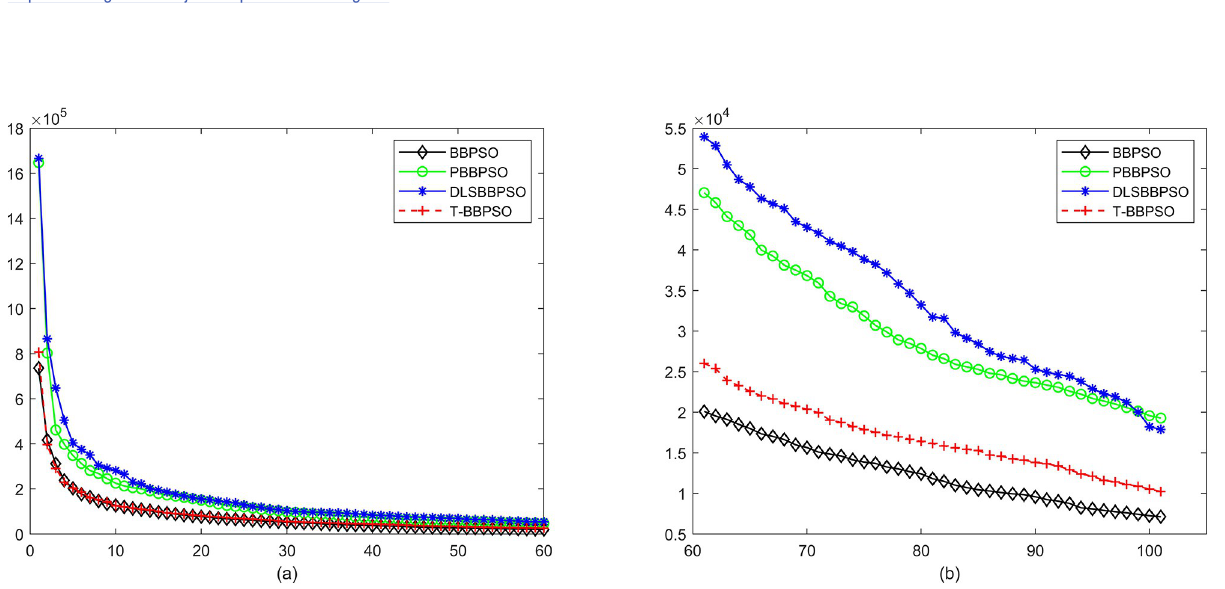
Fig 21. Comparison of convergence speed between BBPSO, PBBPSO, DLS-BBPSO and TBBPSO, f 19 , (a) iteration 0–6000, (b) iteration 6000–10000 the unit is 100 iteration.